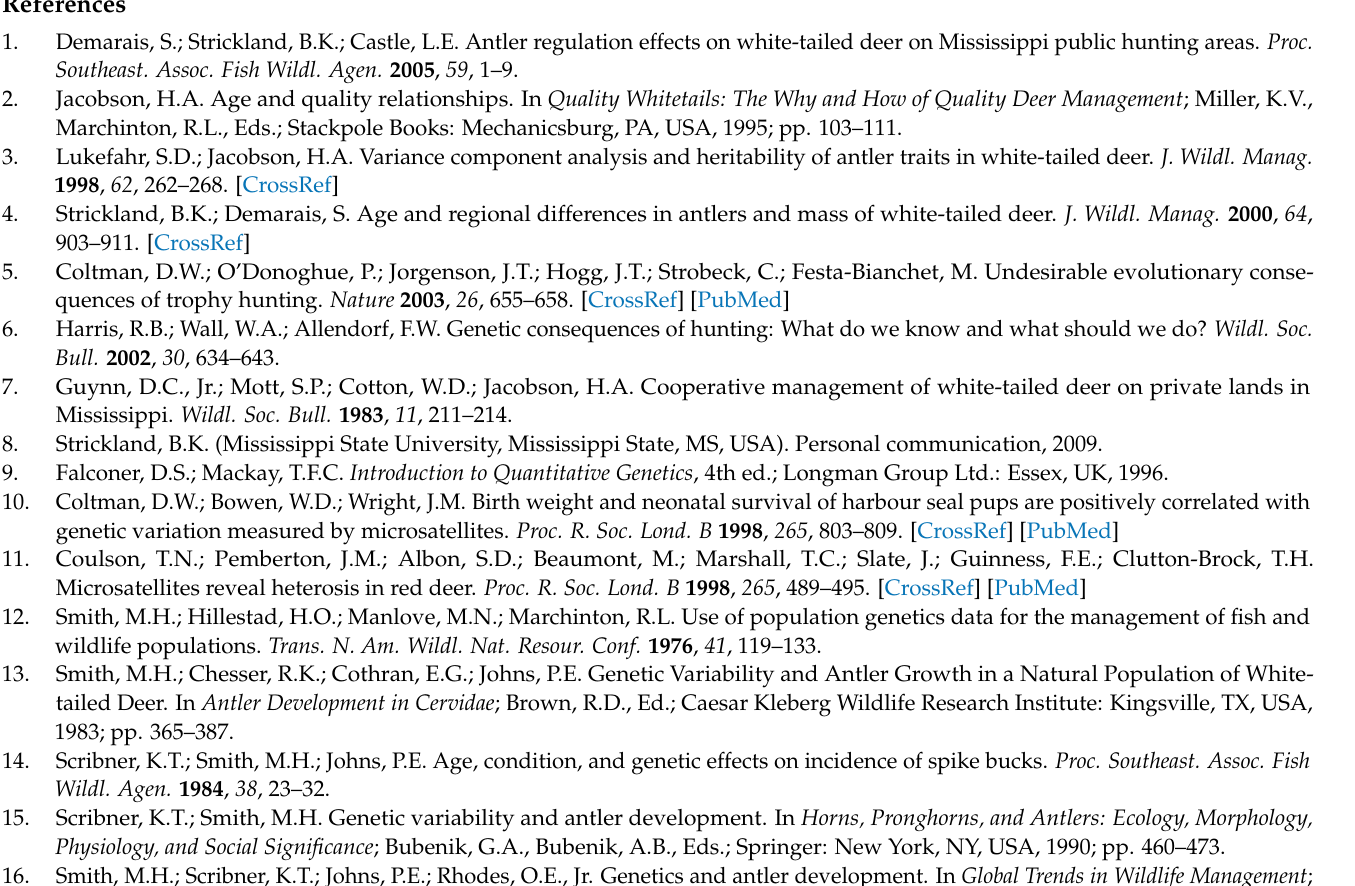
Figure A3. Male white-tailed deer ( Odocoileus virginianus ) exhibiting damage to pedicle of right antler. Photograph by Stephen L. Webb.